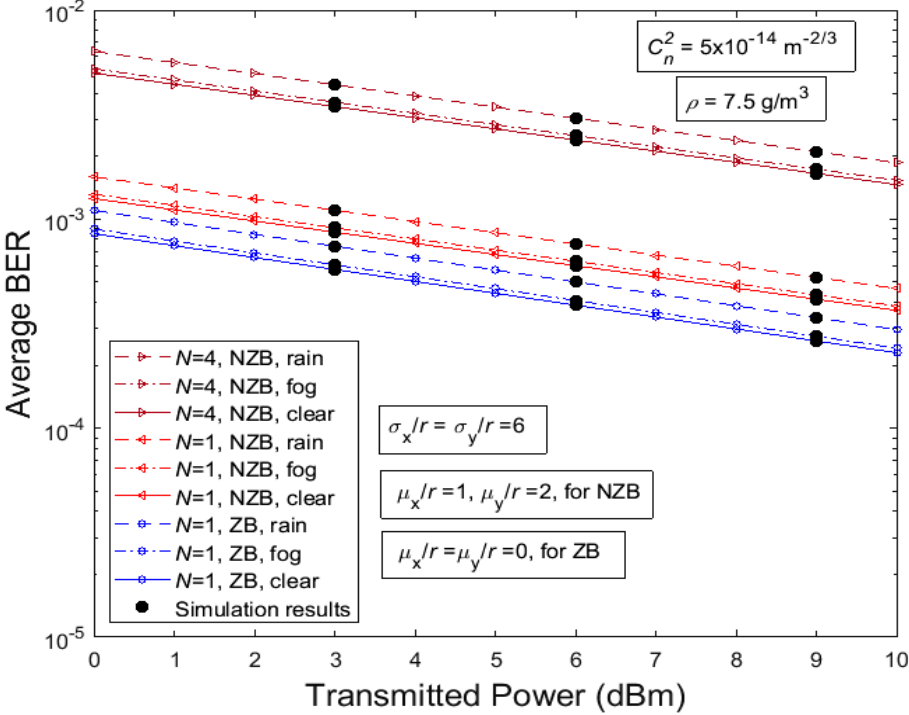
Figure 1. ABER vs. Transmitted power for single-hop and quad-hop THz link configurations under different weather conditions, weak turbulence, FSPL, moderate water vapor concentration and strong generalized pointing errors.